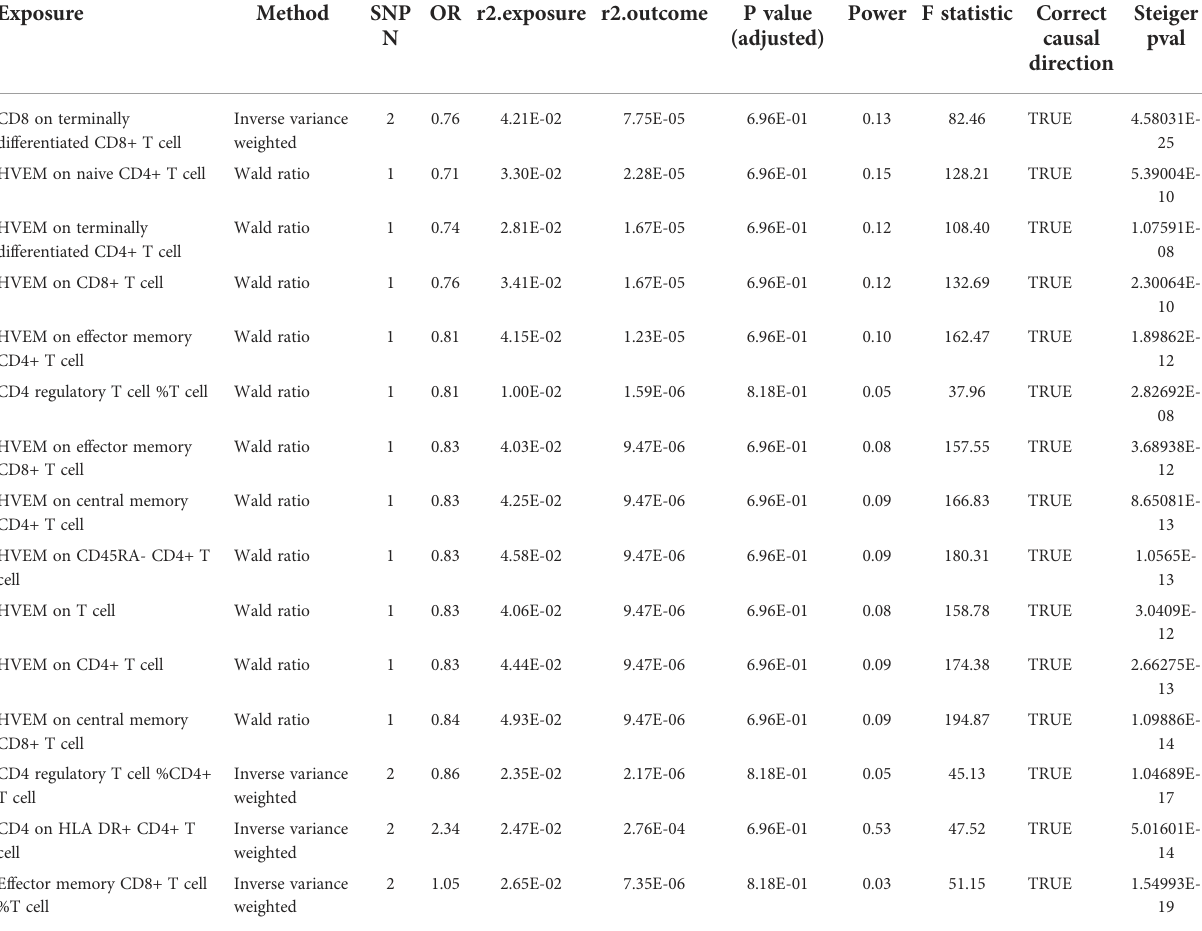
TABLE 3 Detailed MR result in the secondary analysis (FIN